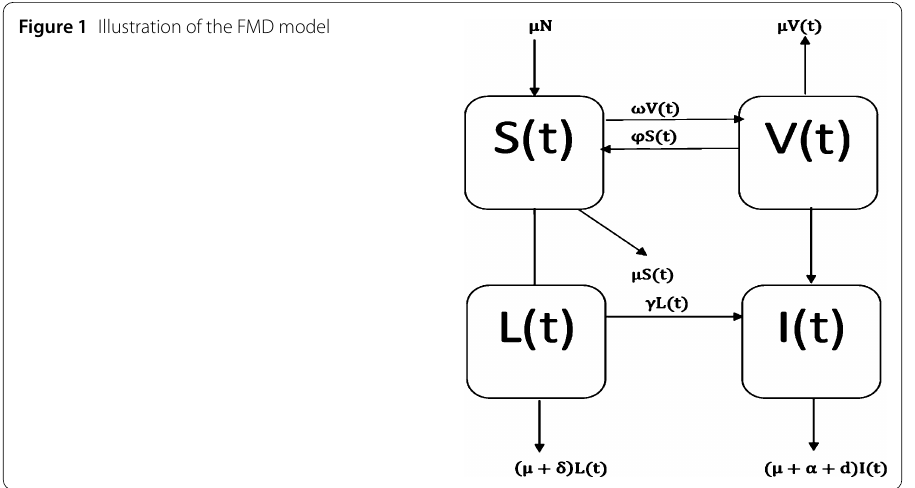
Figure 1 Illustration of the FMD